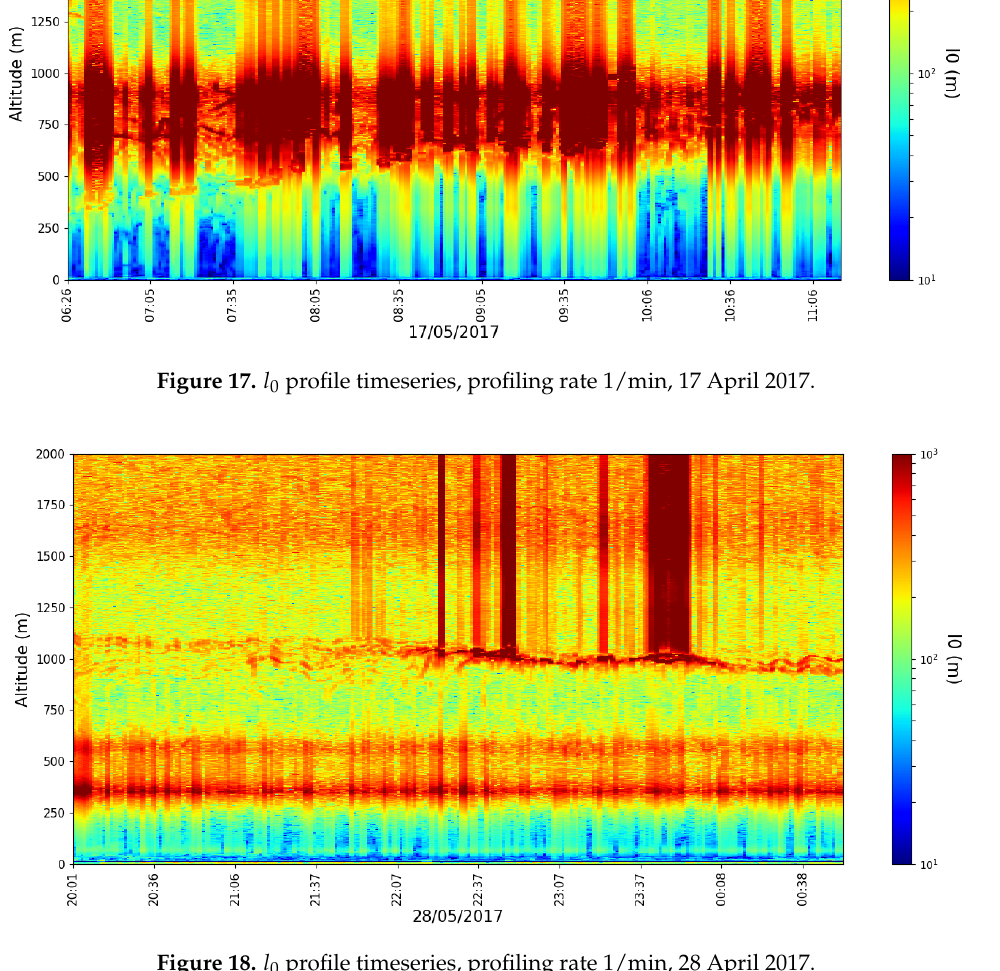
Figure 18. 𝑙 0 profile timeseries, profiling rate 1/min, 28 April 2017. Figure 18. l 0 profile timeseries, profiling rate 1/min, 28 April